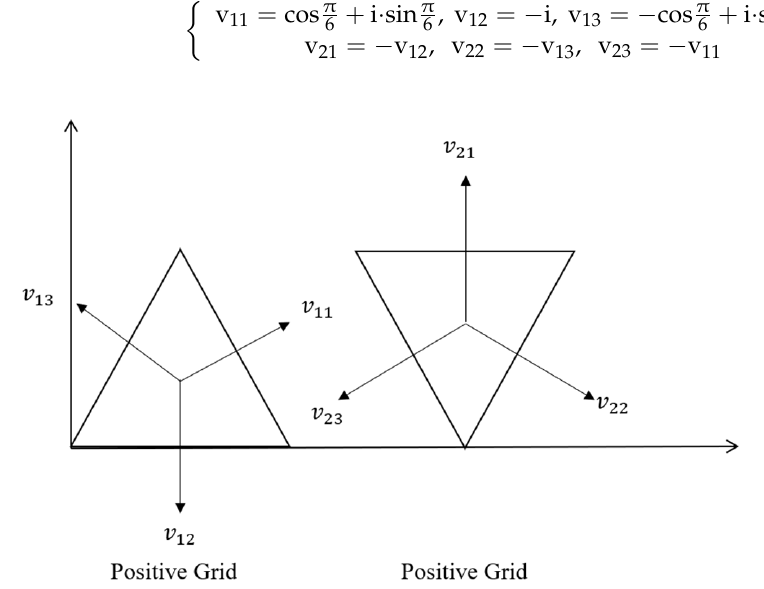
Figure 1. The complex units of the positive and negative grids. First, it is determined whether the initial cell is a positive grid or a negative grid, so as to determine the complex units when the cell expands by edge neighbors. If it is a positive grid, the initial complex units are v 11 , v 12 , and v 13 ; if it is a negative grid, the initial complex units are v 21 , v 22 , and v 23 . Then, according to the initial complex unit of the grid, the expansion complex unit of the cell is determined according to the